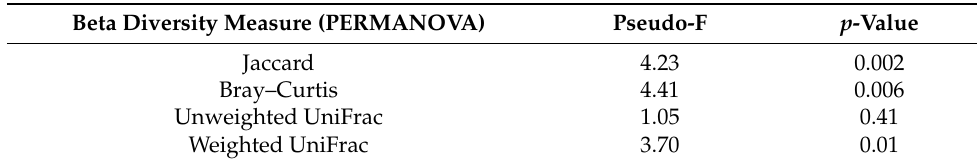
Figure 4. Gut microbiota composition of T. stercorea . ( A ) Taxonomy graph comparing the relative abundances of genera present between larva and adult T. stercorea . The 12 most abundant genera are shown. ( B ) Two-part Venn diagram comparison between laboratory-reared larva and adult of T. stercorea gut microbiota, showing the OTUs shared among life stages: larva (blue) and adult (orange). The numbers in the diagrams represent how many OTUs were unique in life stages or shared between life stages as their areas intersect. Table 2. PERMANOVA analysis based on distance matrices between laboratory-reared larvae and adults of T. stercorea gut microbiota vs. field-collected